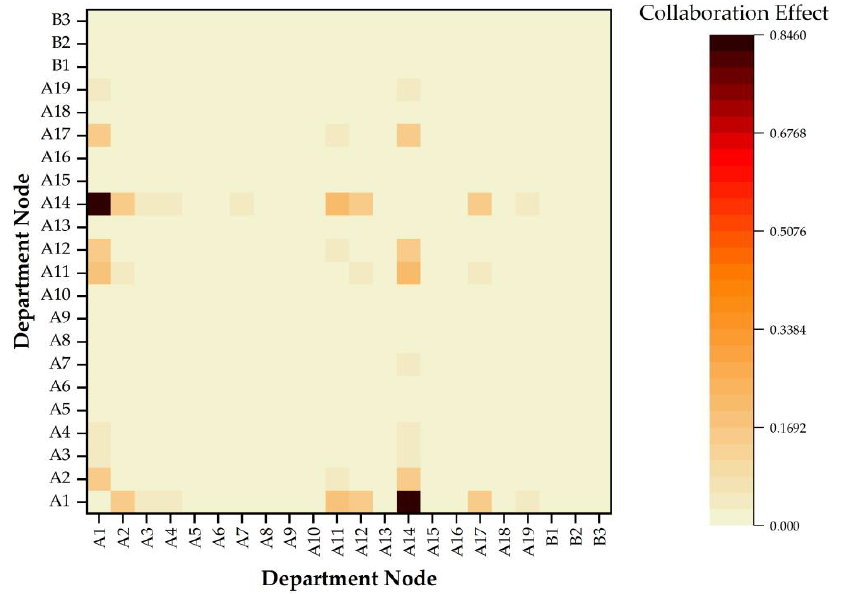
Figure 6. The information collaboration effect measurement results of different node-pairs.